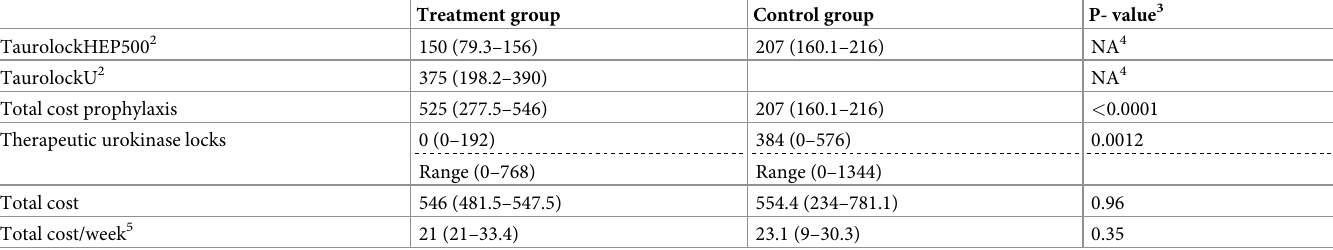
Table 6. Costs of prophylactic and therapeutic catheter locks per patient during the 6-month study period 1 . Treatment